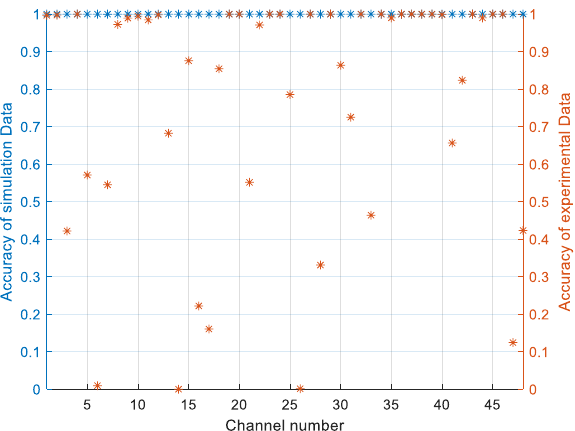
Figure 20. The ResNet-18 validation accuracy of simulation data and testing accuracy of experimental data of all 48 hydrophones.